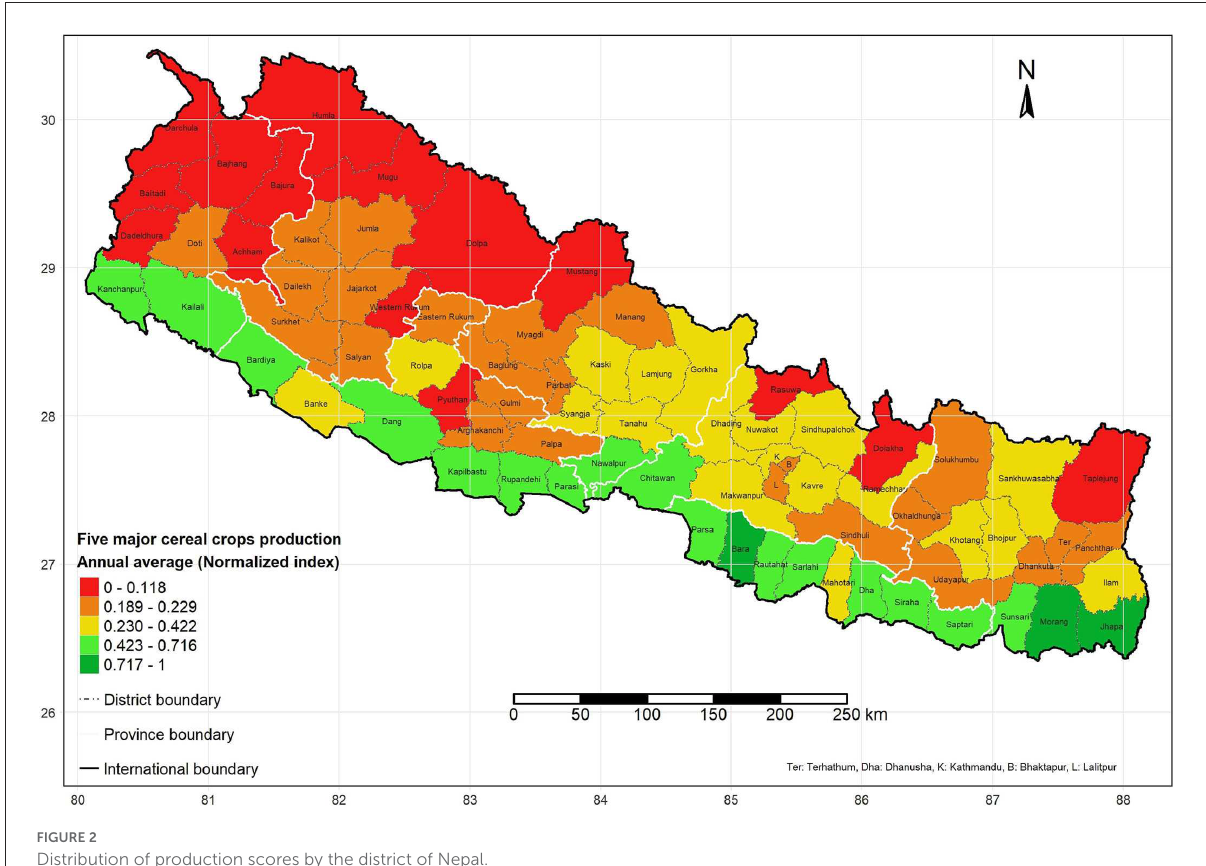
FIGURE2 Distribution of production scores by the district of